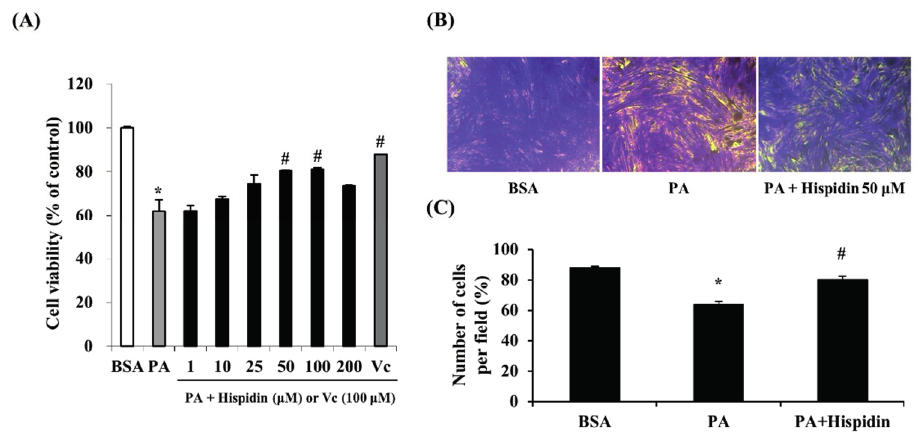
Figure 2. Protective effect of hispidin in palmitate-damaged C2C12 myotubes. ( A ) Effect of hispidin on palmitate-induced cell death in C2C12 myotubes. Cells were treated with 1 to 200 μ M hispidin for 8 h, and then 1 mM palmitate was added for 16 h. Cell viability was determined by the MTT assay. Data represent the mean ± standard error of three independent experiments. * p < 0.05, as compared with only BSA group, # p < 0.05, as compared with PA group. ( B ) Effect of hispidin on palmitate-induced cell loss in C2C12 myotubes. Cells were treated with hispidin 50 μ M for 8 h, and then 1 mM palmitate was added for 16 h. Cell loss was determined by crystal violet staining. ( C ) The number of myotubes per photograph was counted after crystal violet staining using the Image J densitometry software program. The cells treated with only BSA conditioned medium were used as a control. Palmitate was administered by conjugating it to BSA (fatty acid free). BSA, bovine serum albumin; PA,